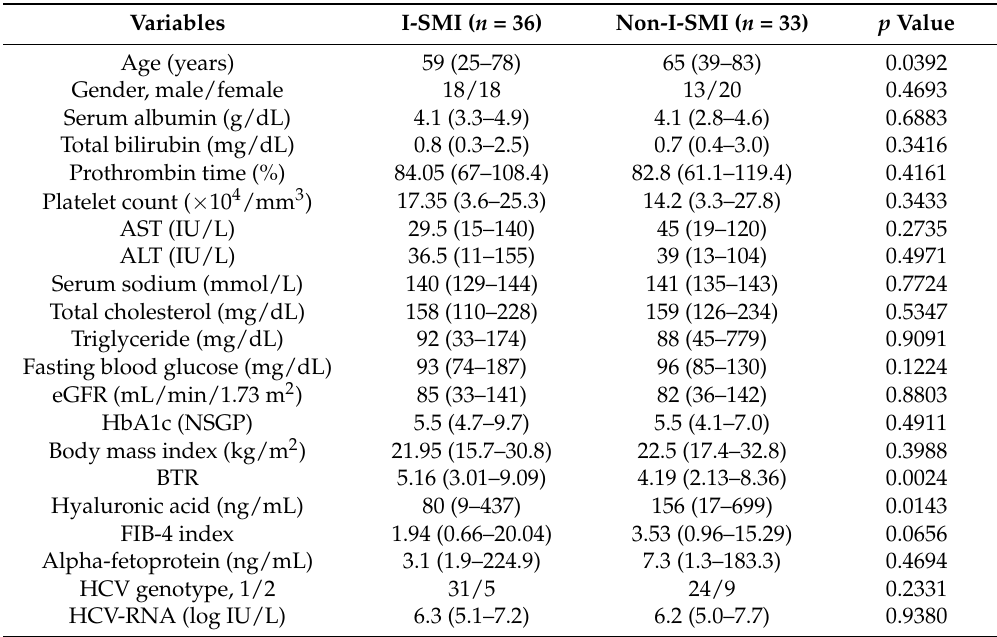
Table 2. Comparison of baseline characteristics between patients with increased SMI (I-SMI, n = 36) and without I-SMI ( n = 33).